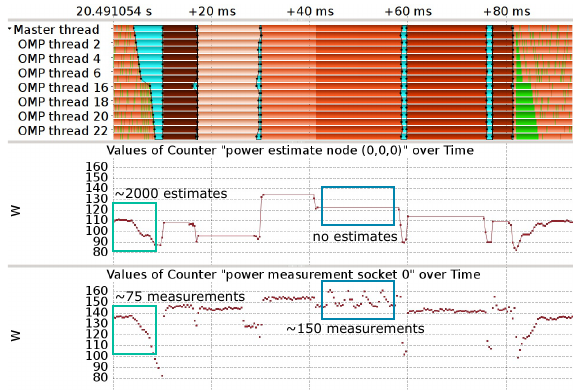
Figure 8: Results of the power estimation for LU.C.1.32 using HAEC-SIM. The top part repre- sents the simulated event timelime of the threads mapped to the (0,0,0) computing node. The middle part represents the estimated power consumption of this node. The bottom part shows the power mea- surements for running the 16 threads on socket 0 of artemis. These measurements are part of the input